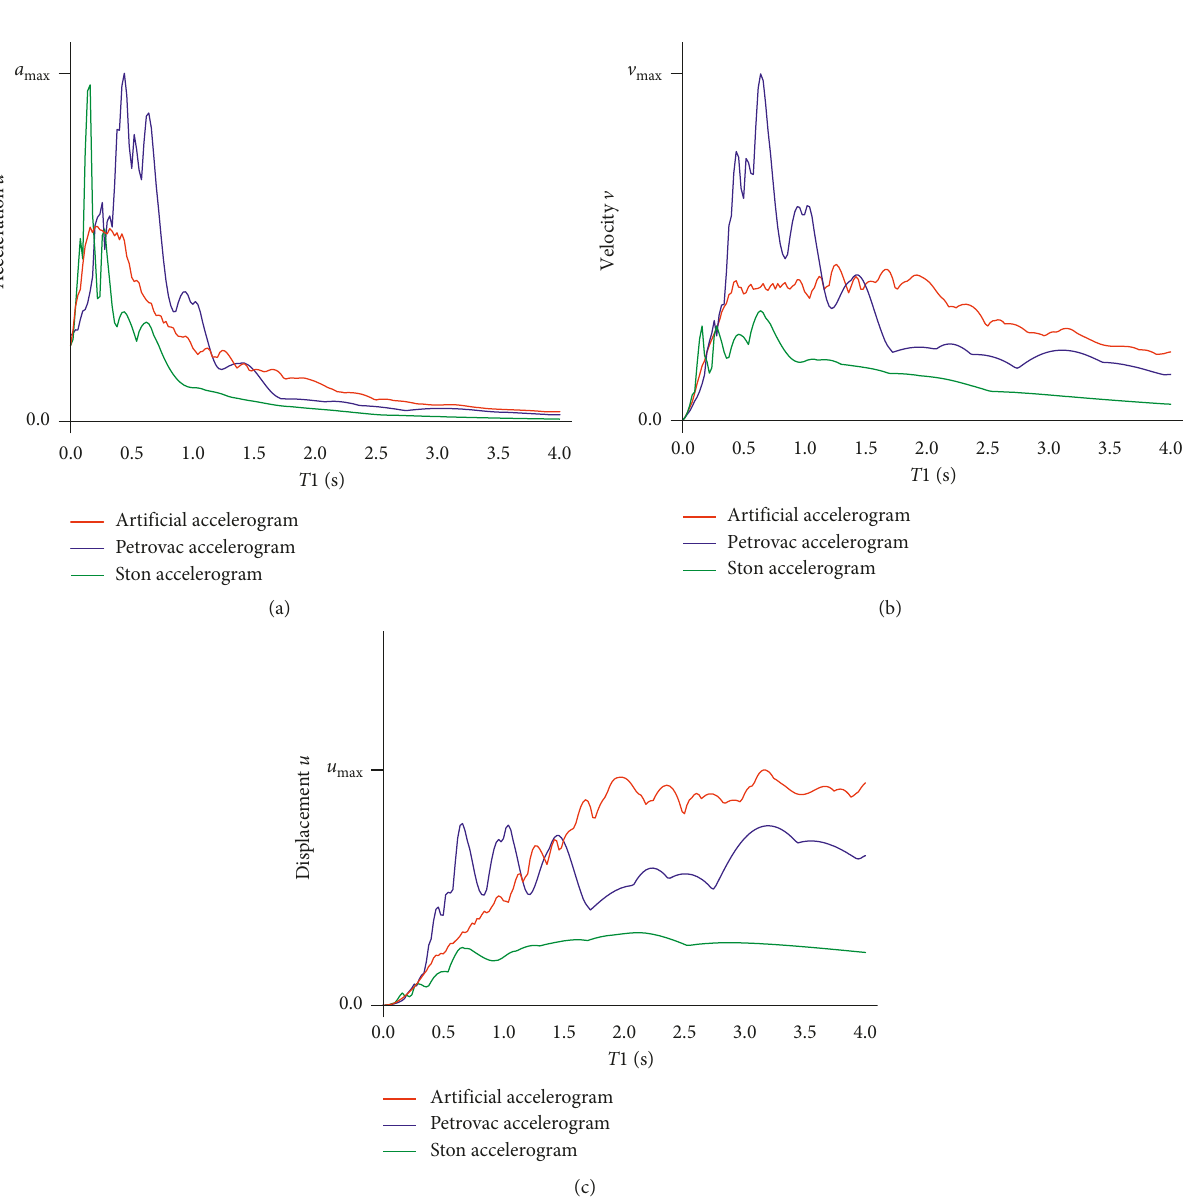
Figure 3: Spectral values for the adopted accelerograms: (a) accelerations; (b) velocities; (c)